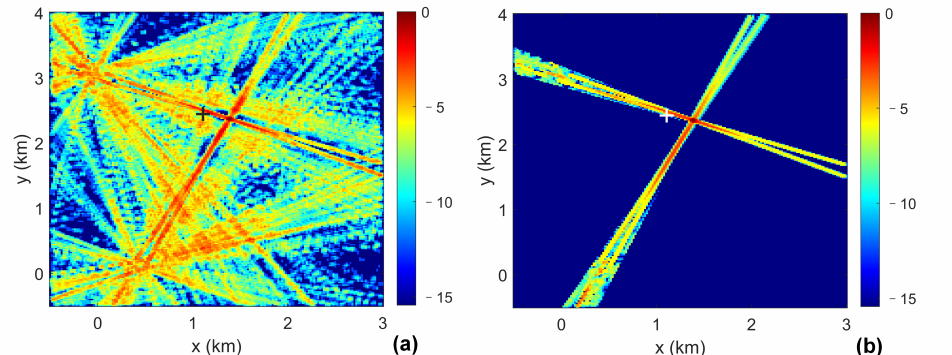
Figure 12. (Color online) ( a ) The inter-array intersection pattern of the Basic-FLFL method; ( b ) The inter-array pattern of the proposed HT-FLFL method. The black or white plus markers indicate the true position of the